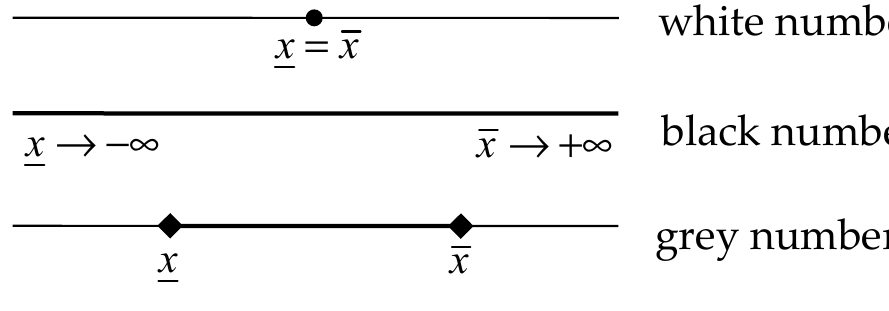
Figure 1. White, black and interval grey numbers.